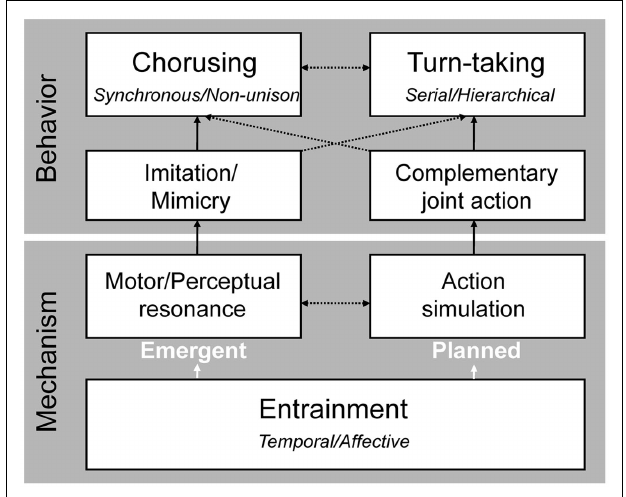
FIGURE 2 | Diagram illustrating dual routes by which entrainment supports mechanisms and behaviors in musical joint action. One route leads to emergent coordination (e.g., automatic imitation and chorusing) via motor and/or perceptual resonance.The other route leads to planned coordination (e.g., complementary joint actions involving turn-taking) through action simulation.The vertical arrows in the figure represent relations between mechanisms and behaviors within each route, while horizontal arrows represent potential areas of overlap between the routes (e.g., imitative behavior may arise through resonance alone or through a combination of resonance and simulation).The dotted arrows imply that the behaviors and mechanisms at each level are not mutually exclusive, and may exist in hybrid forms (e.g., non-unison chorusing and hierarchical